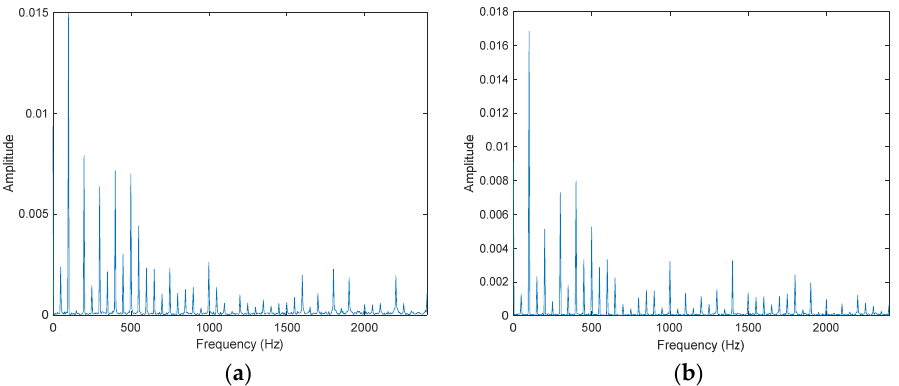
Figure 2. Vibration amplitude and frequency characteristic curves: ( a ) Transformer light load operating conditions; ( b ) Transformer heavy load operating conditions.